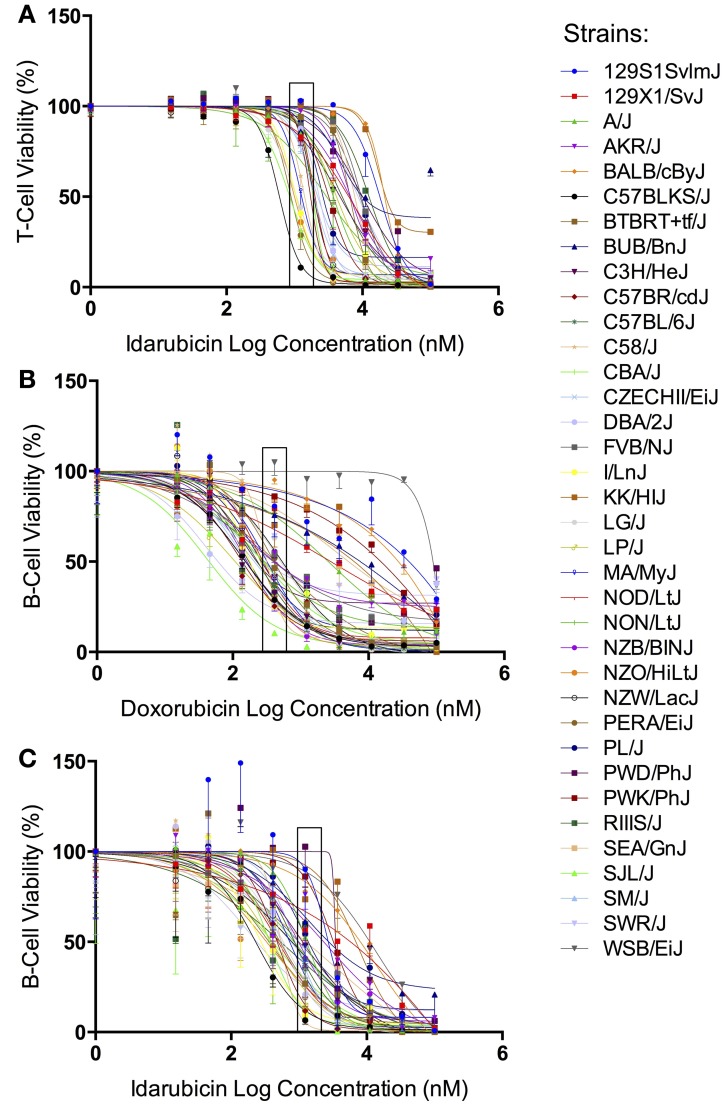
Phenotypes for GWAS. Dose-response curves reflecting interstrain variation in viability are shown for T-cells exposed to idarubicin (A), B-cells exposed to doxorubicin (B), and B-cells exposed to idarubicin (C). Thirty-six strains are represented: 129S1/SvImJ, 129X1/SvJ, A/J, AKR/J, BALB/cByJ, BTBR T+ Itpr3tf/J, BUB/BnJ, C3H/HeJ, C57BLKS/J, C57BL/6J, C57BR/cdJ, C58/J, CBA/J, CZECHII/EiJ, DBA/2J, FVB/NJ, I/LnJ, KK/HiJ, LG/J, LP/J, MA/MyJ, NOD/LtJ, NON/LtJ, NZB/BINJ, NZO/HiLtJ, NZW/LacJ, PERA/EiJ, PL/J, PWD/PhJ, PWK/PhJ, RIIIS/J, SEA/GnJ, SJL/J, SM/J, SWR/J, and WSB/EiJ. Concentrations used to generate genome-wide significant QTL (respectively 1, 0.3, and 3 μM) are enclosed with a black box.